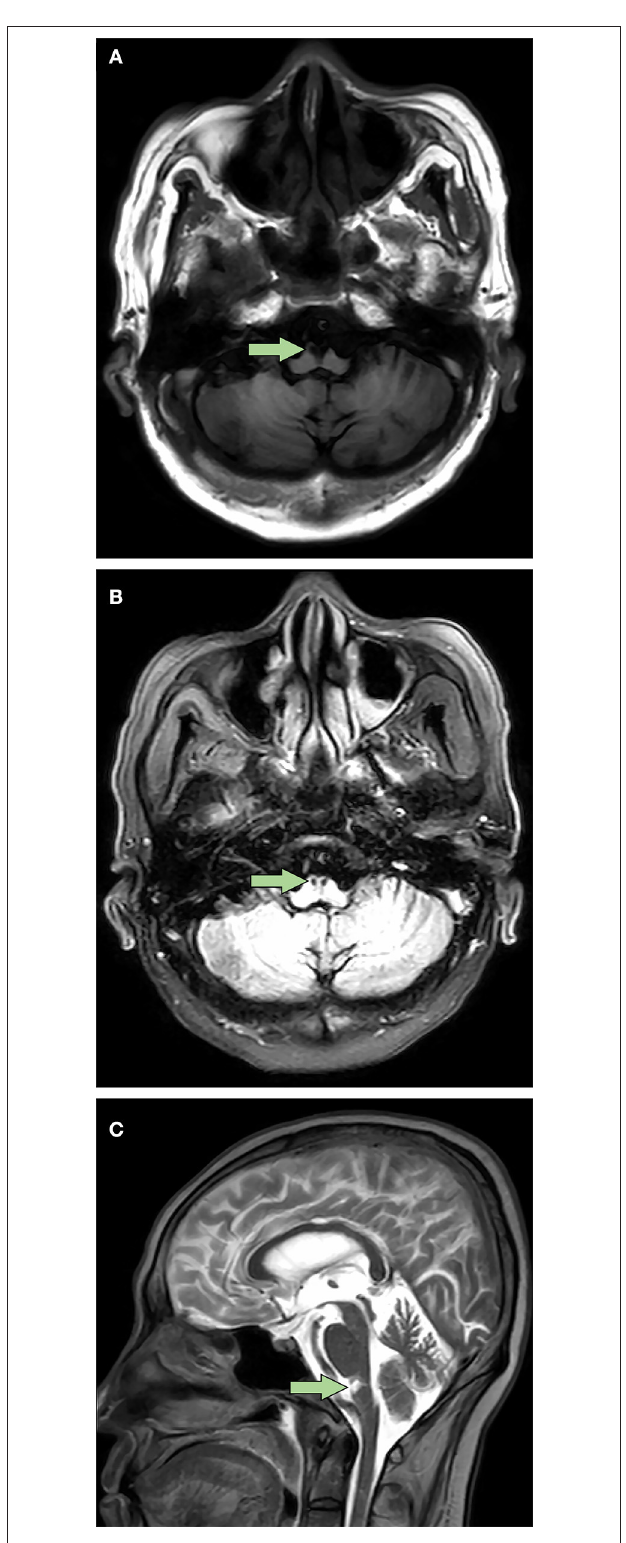
FIGURE 2 | Bilateral medial medullary infarction with “snake eyes appearance” in magnetic resonance imaging 9 months after onset. (A) Axial